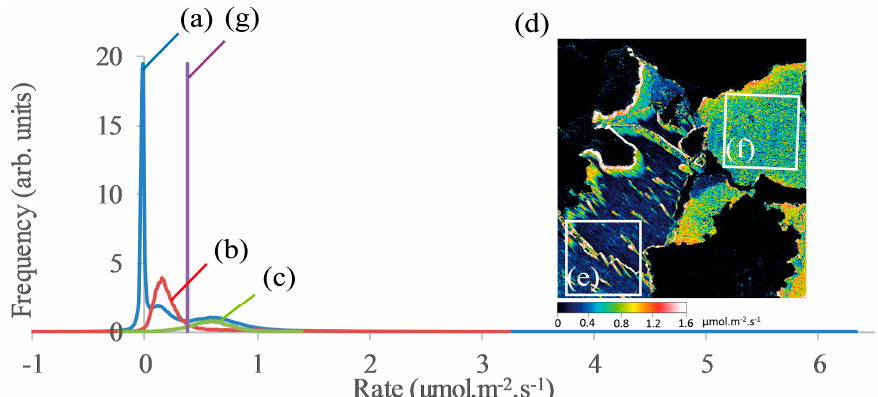
Figure 1. Selection of the calcite patches with characteristic surface dissolution morphologies: ( a ) rate spectrum of the full rate map showed in ( d ); ( b ) rate spectrum of the sub-section ( e ) from the full rate map ( d ); ( c ) rate spectrum of the sub-section ( f ) from the full rate map ( d ); ( g ) rate average calculated from the volume of calcite lost and the map’s surface area. The sub-section’s rate modes fit the rate modes of the full rate map. The highest frequency mode at zero rate corresponds to practically unreactive grains (black areas in the rate map).